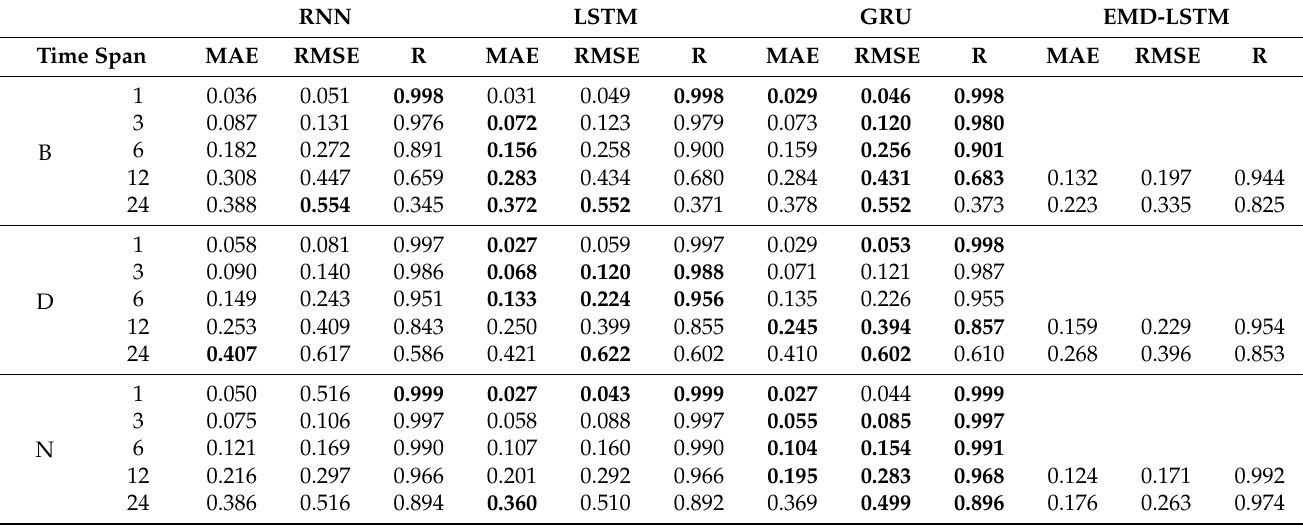
Table 3. Error of different methods at each point. The bold text in the table represents the optimal forecast value for different locations at the same forecast